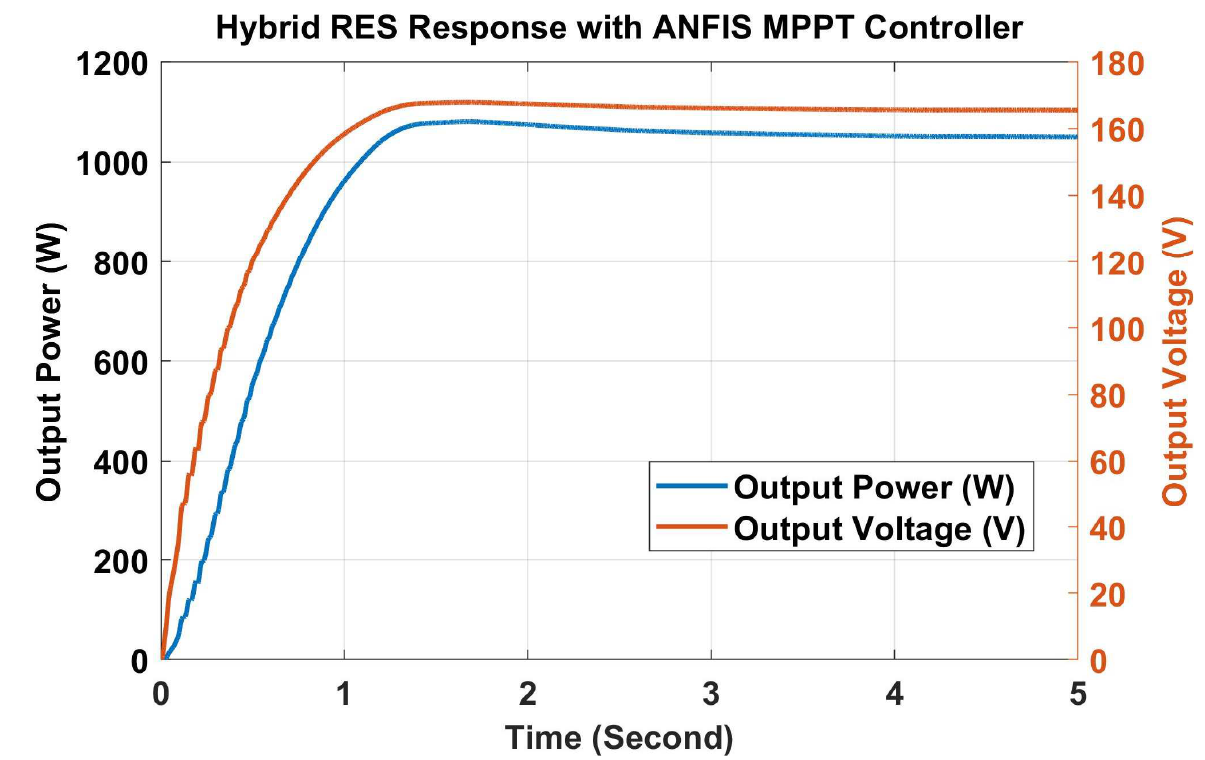
Figure 34. Output Power and Voltage of Hybrid RES with AN-FIS MPPT.